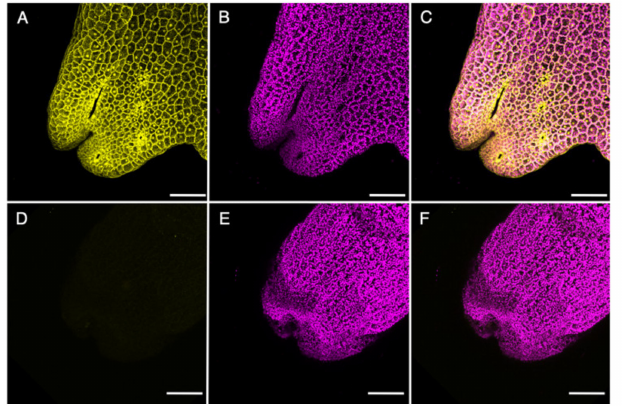
Figure 5. Transformed R. fluitans 001TC plant expressing mCherry. ( A – C ) pro Mp EF1 α :: mCherry T1 line. ( D – F ) Wild type control. ( A , D ) mCherry fluorescence channel. ( B , E ) Chlorophyll a autofluorescence channel. ( C ) Merged channels of (A) and (B). ( F ) Merged channels of (D) and (E). Scale bars 200 µ